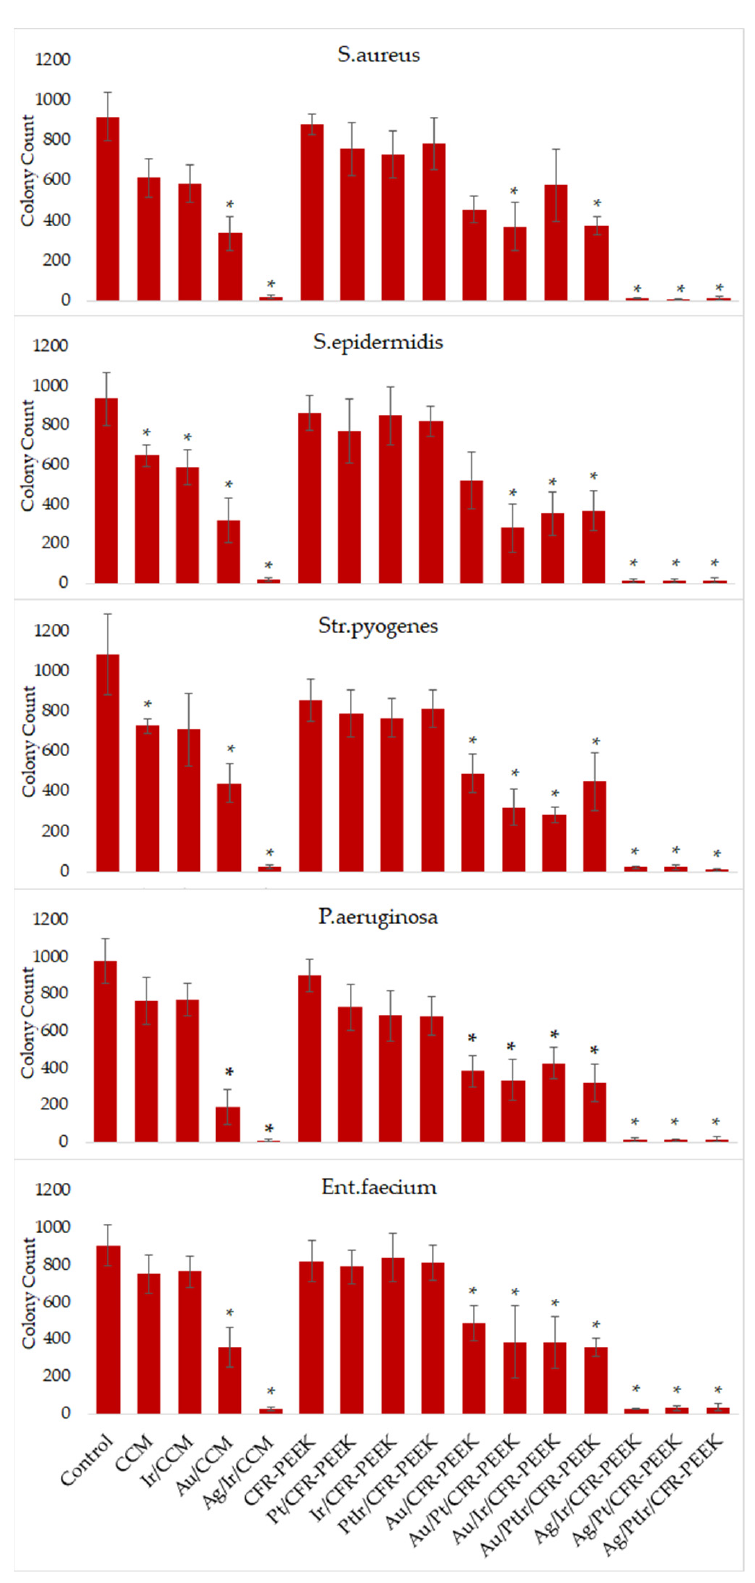
Figure 11. Profile300 of antibacterial activity of novel noble metal-coated materials against S. aureus ,